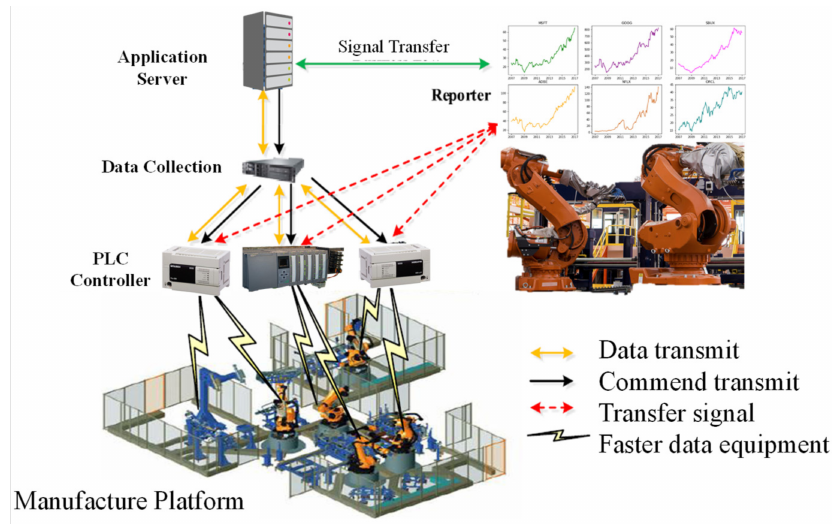
Figure 2. The smart factory uses PLC devices to monitor various equipment